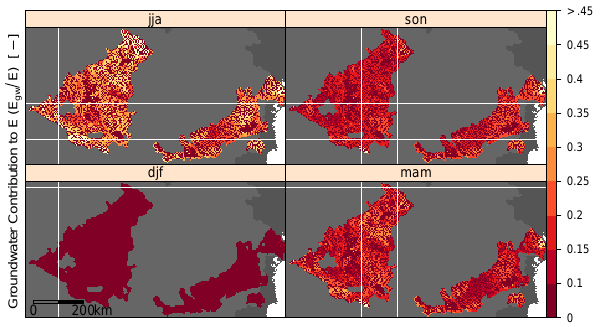
Fig. 5. Relative groundwater contribution to evaporation, per sea- son. In winter (lower left), groundwater does not contribute to evap- oration. From spring to late fall, there is a significant contribution of groundwater to sustain evaporative fluxes.